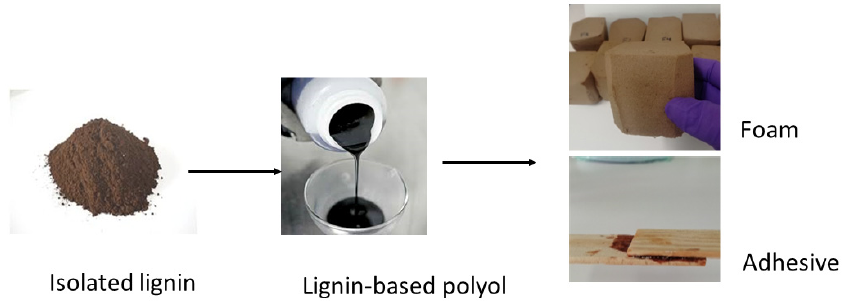
Figure 2. Polyurethane products from lignin-based polyol (LBP).